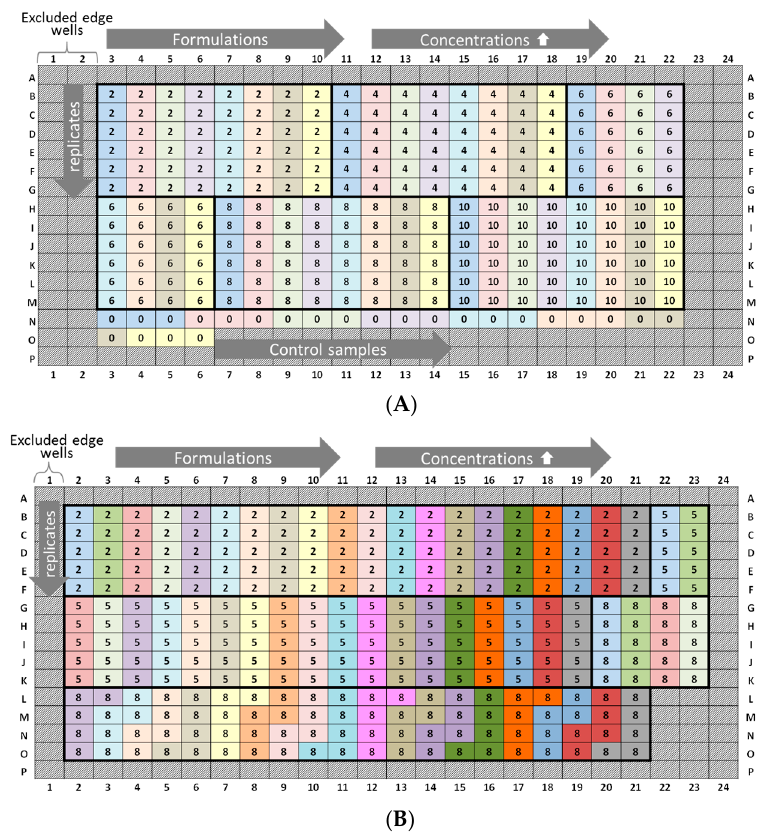
Figure 11. Plate design recommendations for k D determination and the screening of prototype formulations. ( A ) “Low risk”: 8 formulations (marked by blue to yellow), based on a horizontally arranged concentration series (2, 4, 6, 8, and 10-mg/mL API), and 6 replicates of each concentration are positioned vertically (=240 sample wells, elapsed time (well B3 → M22): 5 h). Control samples are optionally placed at the end positions. Total net amount API: 44 mg. ( B ) “High quantity”: 20 formulations (marked by blue to gray), based on a horizontally arranged concentration series (2, 5, and 10-mg/mL API), and 5 replicates of each concentration are positioned vertically (=300 sample wells, elapsed time (well B2 → O21): 6.25 h). Placebo samples are not placed on the microtiter plate. Total net amount API: 50 mg.